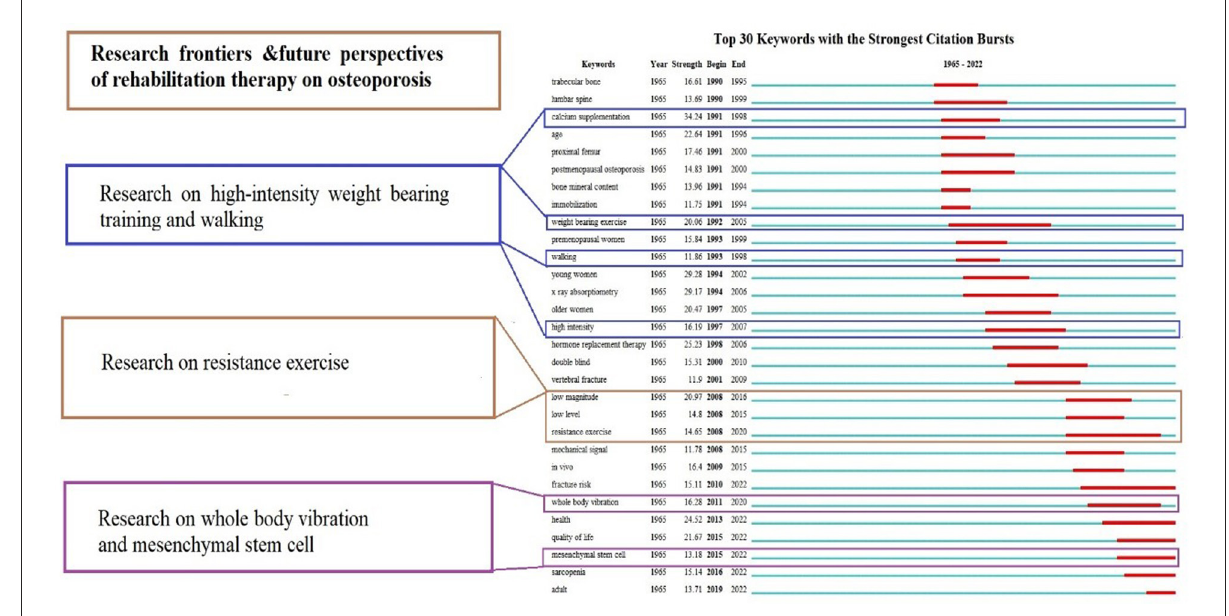
FIGURE9 Top 30 keywords with the strongest citation burst in osteoporosis rehabilitation-related